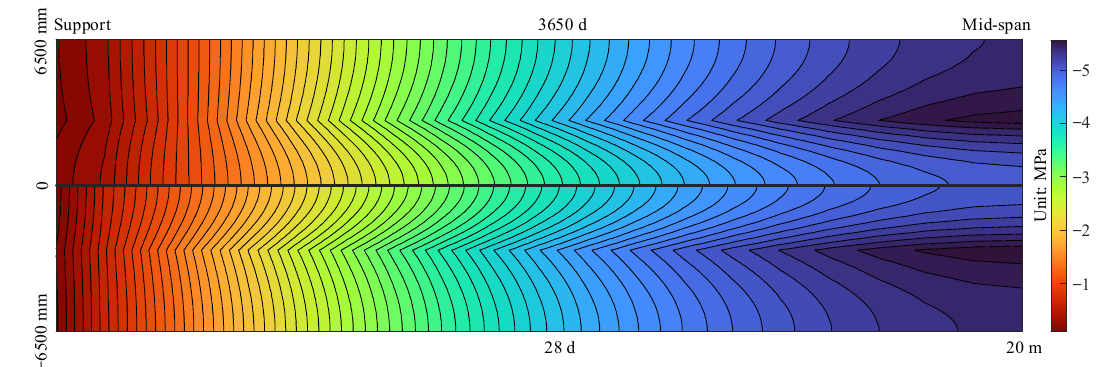
Figure 18. Stress at the bottom flange of the steel beam of the composite beam (time-dependent analysis). ( a ) Distribution along width; ( b ) Change with time at mid-span section. To better show the time-dependent influence, the composite beam on the 3650th day was analyzed. Figure 19 shows the stress distribution on the concrete slab on the 28th and 3650th days. Figure 20 shows the stress distribution at the steel bottom on the 28th and 3650th days. The stress on the concrete slab decreases over this period (28th to 3650th day), and the stress at the bottom flange of the steel beam increases. These results indicate that the creep of concrete produces an unloading effect on the concrete slab.